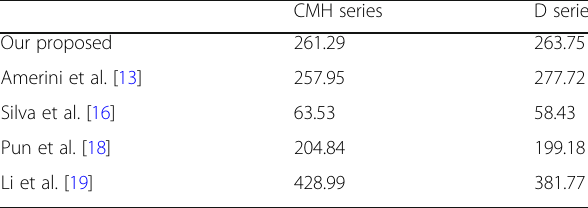
Table 11 Average execution time per image in second CMH